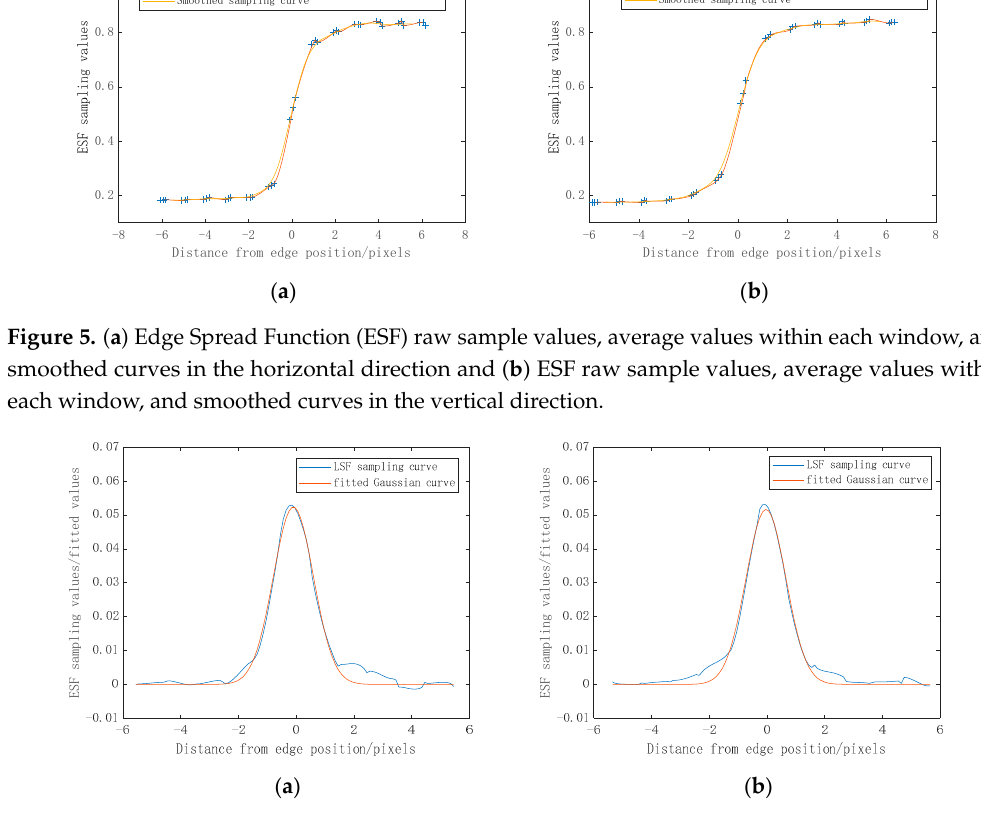
Figure 6. ( a ) Edge Line Spread Function (LSF) curve and fitted Gaussian curve in the horizontal direction and ( b ) Edge LSF curve and fitted Gaussian curve in the vertical direction.